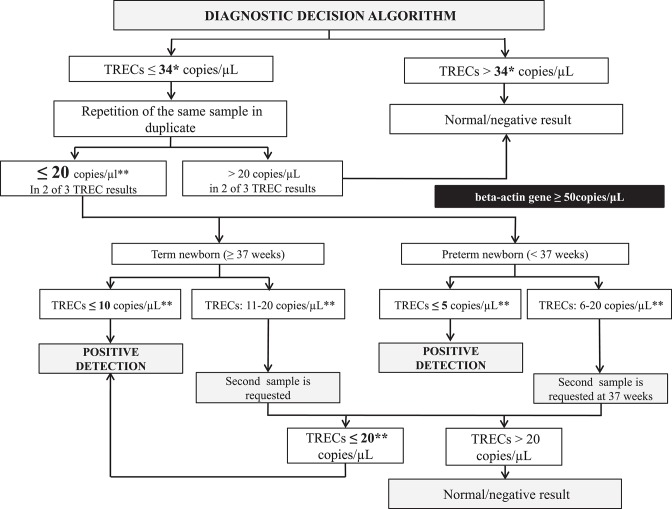
SCID NBS detection decision algorit hm. *The retest cutoff was changed from 34 to 24 copies/μL in 2018. **If beta-actin gene <50 copies/μL a second sample was requested because the sample was considered of unsatisfactory quality. TRECs, T-cell receptor excision circles.